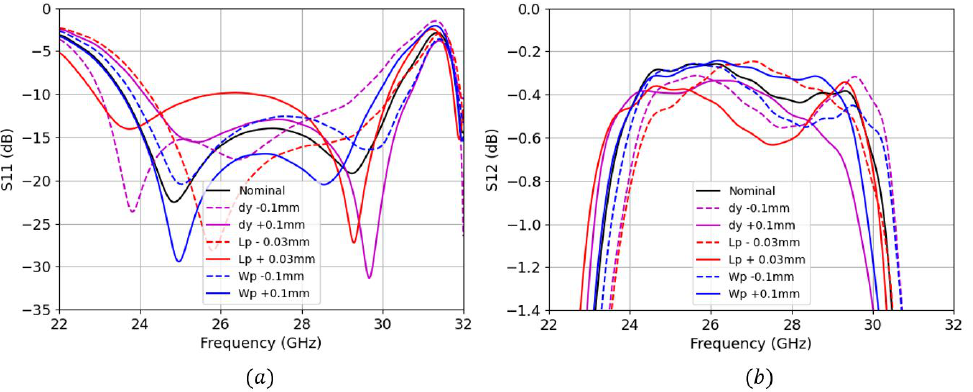
Figure 5. Top-side parametric study of S-parameters ( a ) input reflection coefficient ( b ) insertion losses.